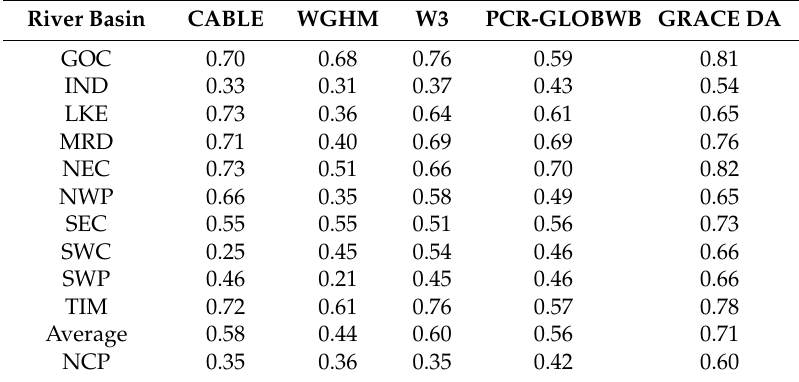
Table 1. The correlation coefficient ( ρ , 5% significance level) between GRACE observation and the ∆ TWS estimates from four different models and GRACE DA in different study regions (see full name in Figure 1). The averaged value of Australia is also given.